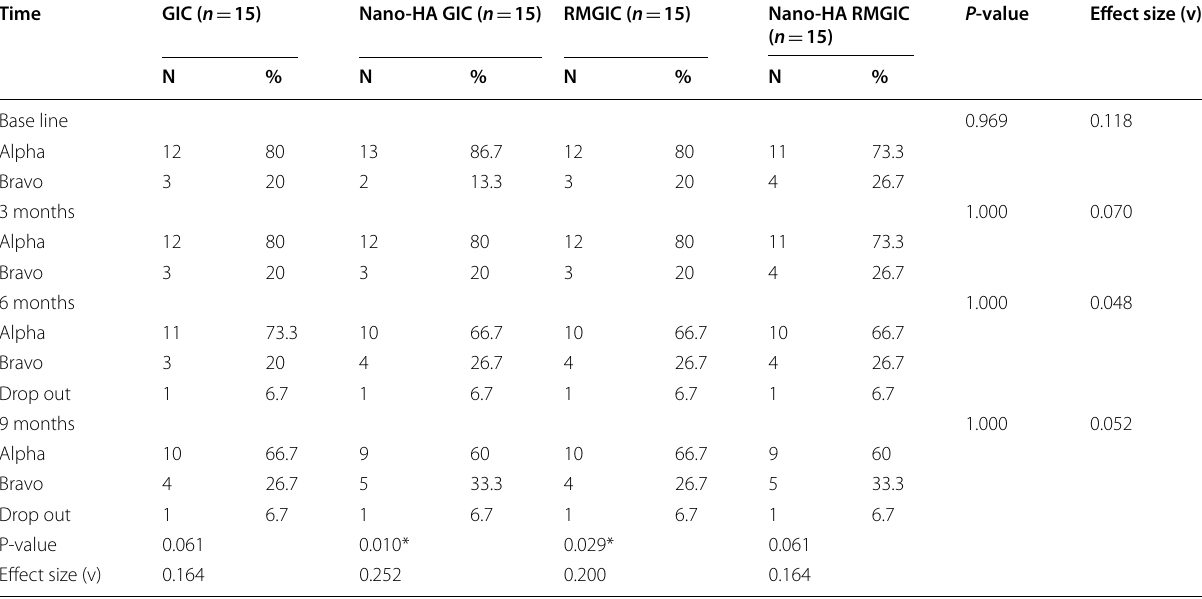
*Significant at P 0.05 ≤ Table 6 Fisher’s exact test results and descriptive statistics for comparison between surface texture in the four groups